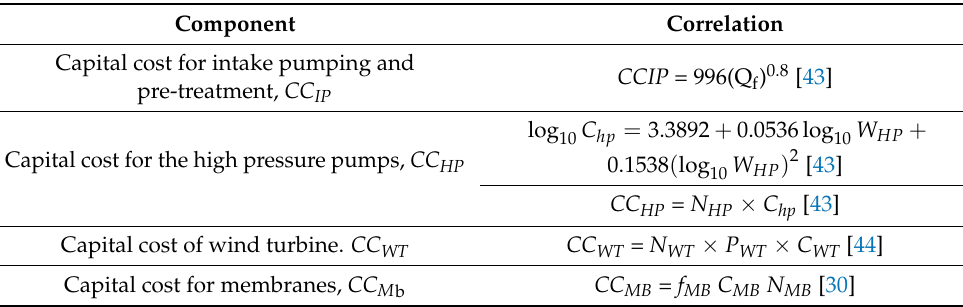
Table A1. Fixed Capital